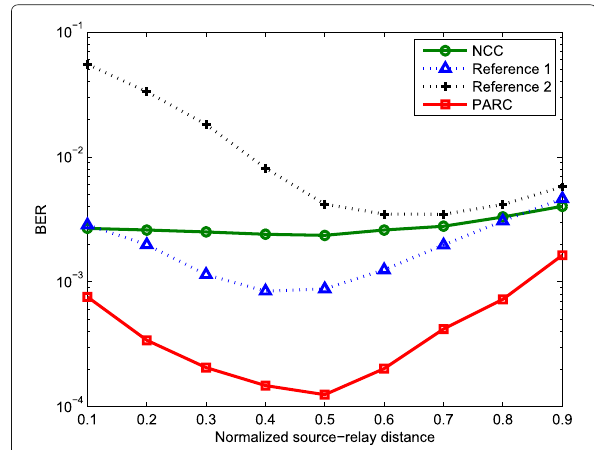
Fig. 6 Performance comparison between PARC and the references for various relay’s locations. Normalized source-relay distance is measured by the source-relay distance divided by the source-destination distance. Channel code [25 33 37], SNR = 10 dB